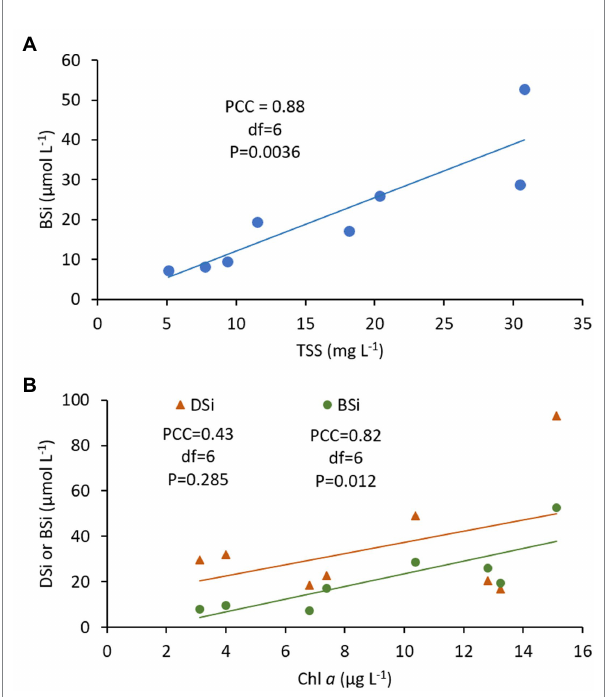
FIGURE 4 Pearson’s correlation analysis of volume-weighted mean concentrations of (A) biogenic Si (BSi) with total suspended solids (TSS) and, (B) dissolved Si (DSi) and biogenic Si (BSi) with chlorophyll a (Chl a ), showing Pearson’s correlation coefficient (PCC), degrees of freedom ( df ), p value and trend line. Data are from the 2014 tidal flux study at the Cell 1B inlet, Poplar Island, Chesapeake Bay (Table 2).